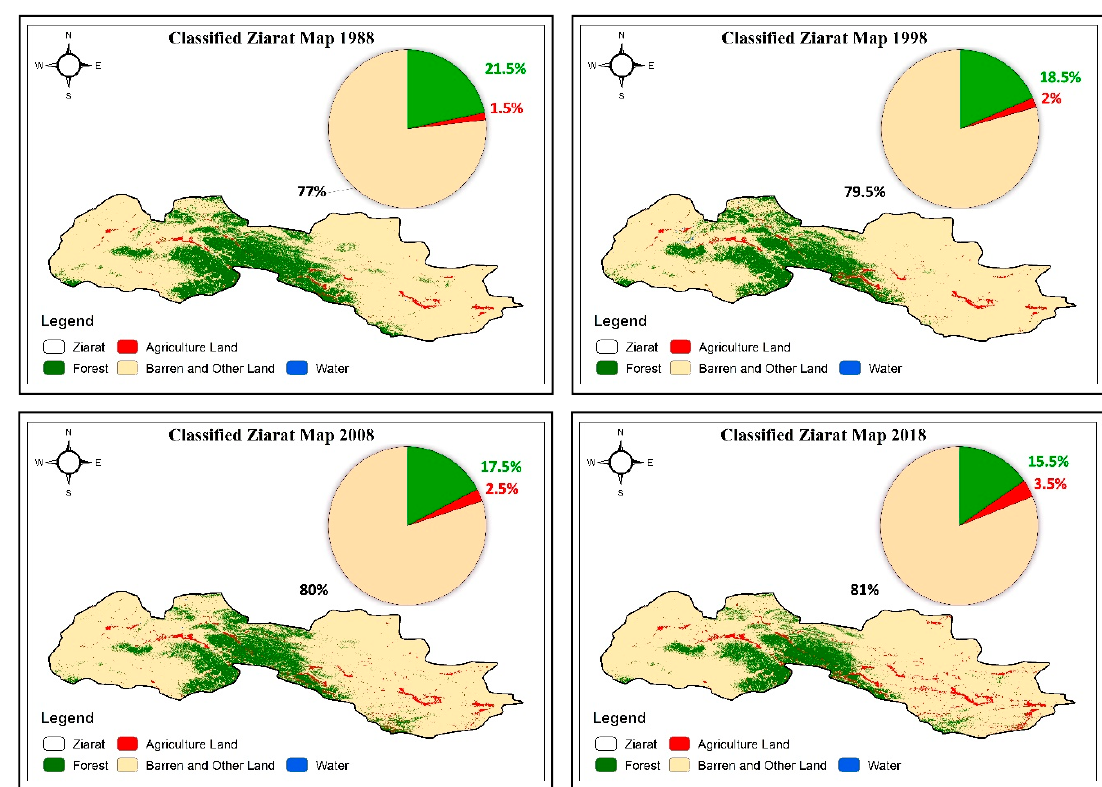
Figure 3. Land-use and land-cover (LULC) maps of the study area for the year 1988, 1998, 2008 and 2018.